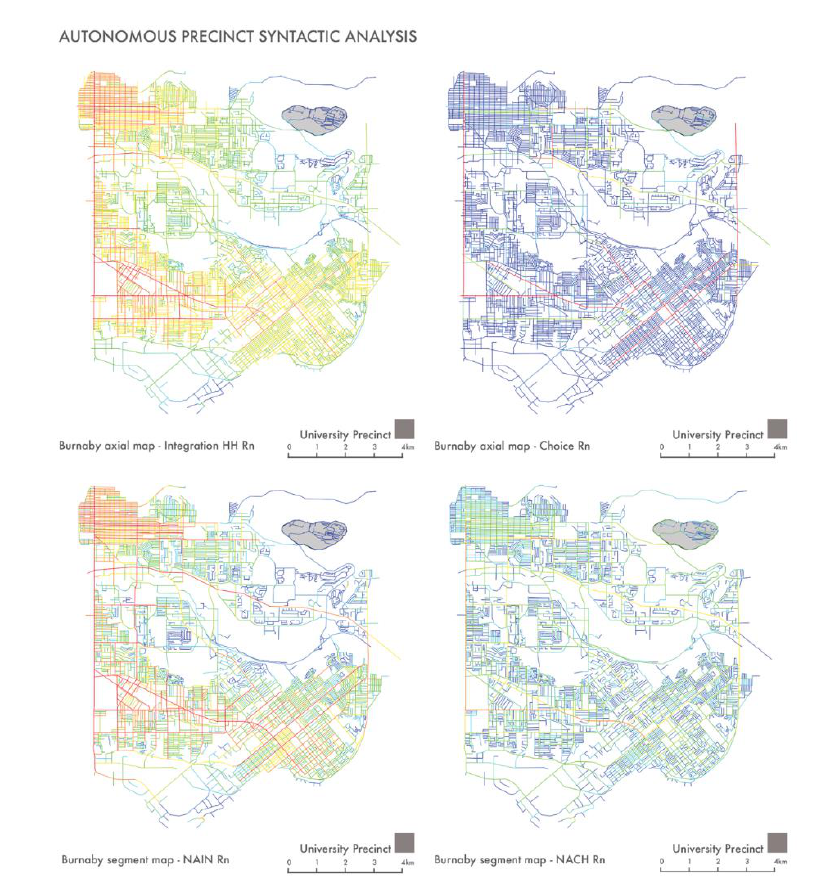
Figure 2 Burnaby Axial and Segment Maps - Simon Fraser University Campus